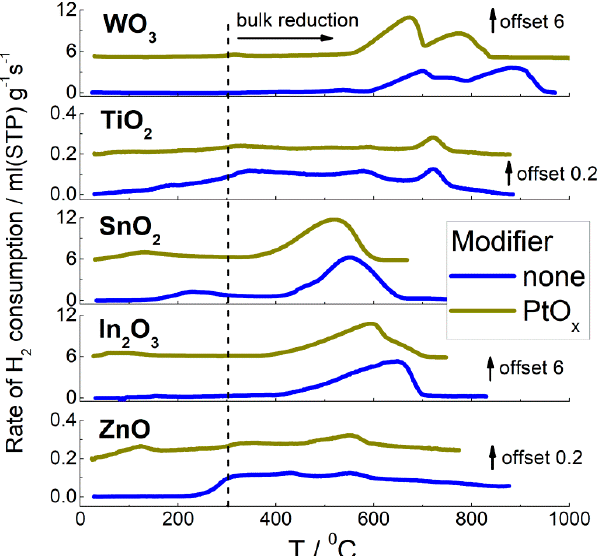
Figure 3. TPR patterns of pristine and PtO x − modified metal–oxide semiconductors.